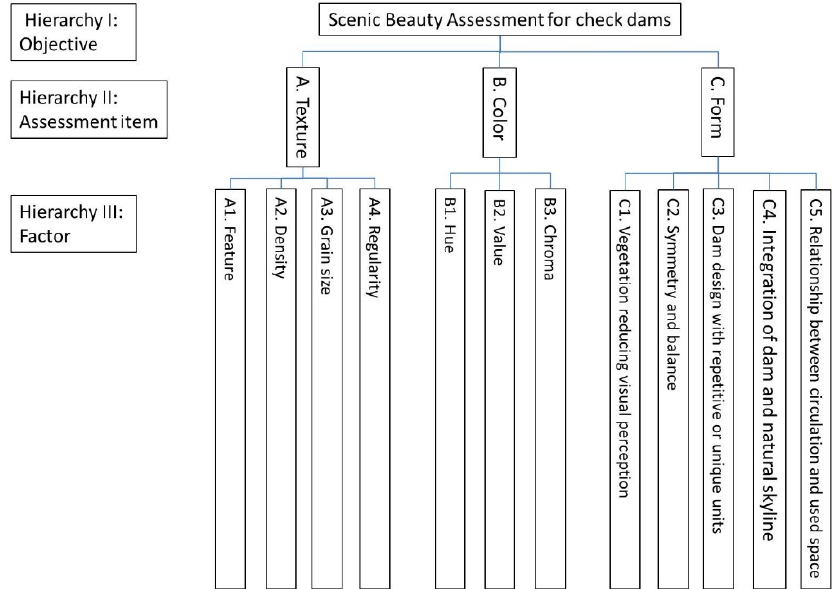
Figure 1. Structure of landscape assessment factors in check dam.